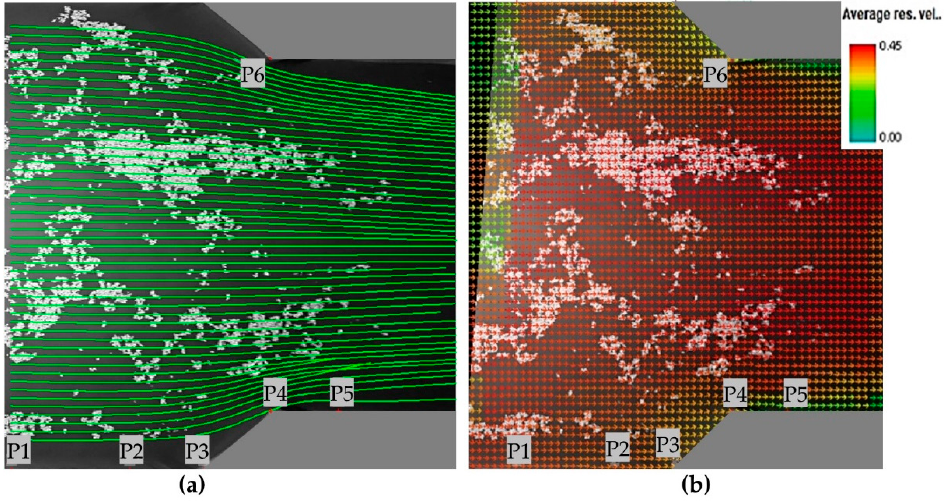
Figure 15. ( a ) Streamlines and ( b ) velocity vectors for B 2 /B 1 = 0.75 and Q = 0.138 m 3 /s.